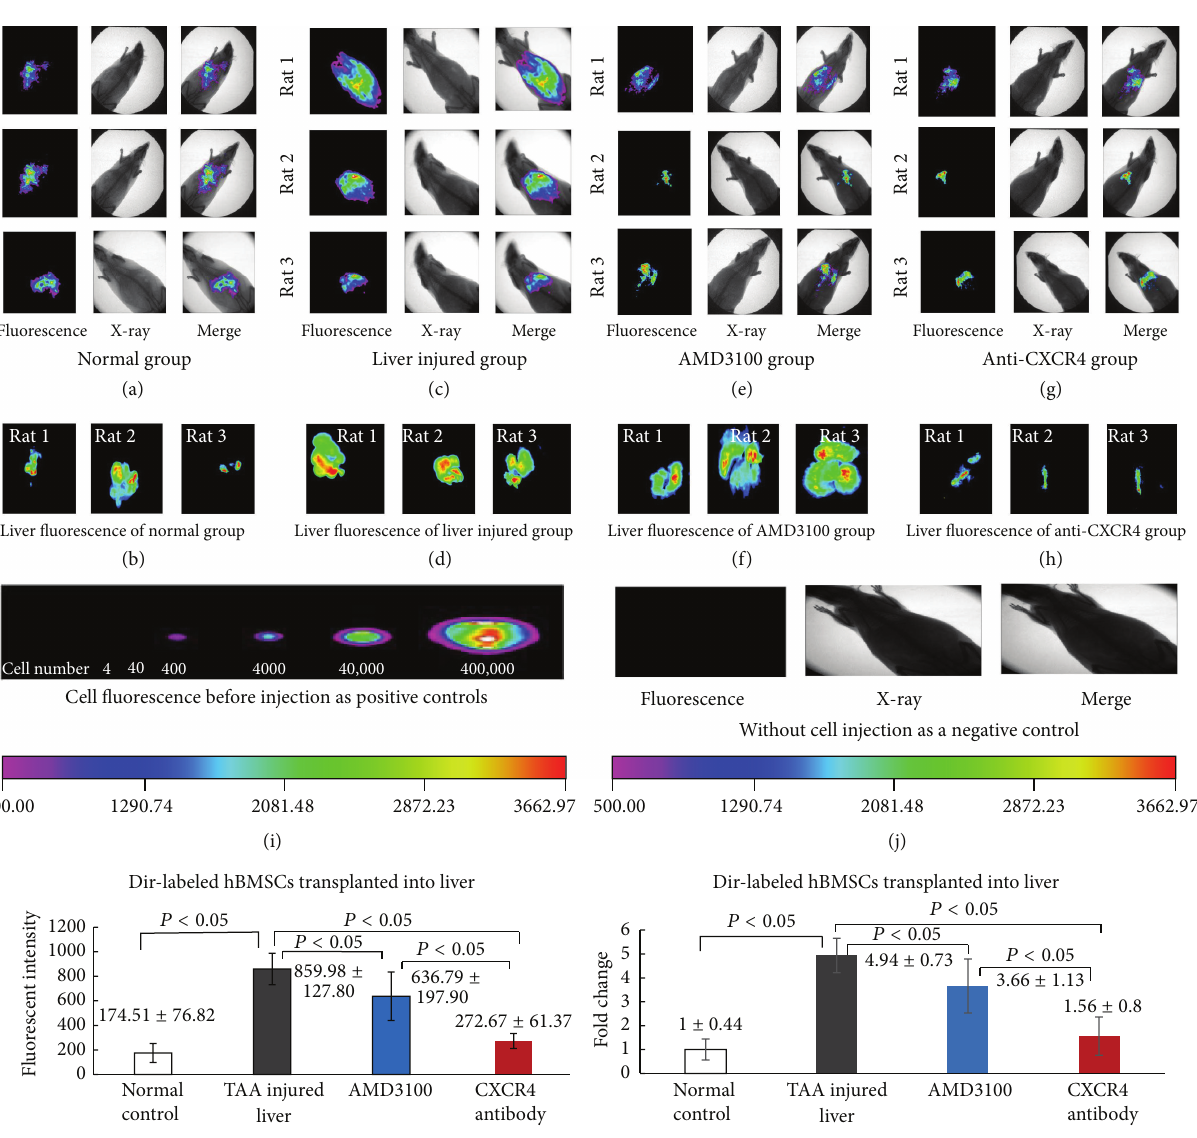
Figure5:BMSCsmigrationininjuredliverinhibitedbyanti-CXCR4antibodyandAMD3100.(a)Thefluorescentintensityofnormalratsafter Dir-labeled BMSCs injection; (b) the fluorescent intensity of dissected normal livers after Dir-labeled BMSCs injection; (c) the fluorescent intensity of rats with TAA induced liver injury after Dir-labeled BMSCs injection; (d) the fluorescent intensity of dissected TAA injured livers after Dir-labeled BMSCs injection; (e) the fluorescent intensity of rats with TAA induced liver injury after Dir-labeled BMSCs and AMD3100 injection at the same time; (f) the fluorescent intensity of dissected injured livers after Dir-labeled BMSCs and AMD3100 injection at the same time; (g) the fluorescent intensity of rats with TAA induced liver injury after anti-CXCR4 antibody pretreated and Dir-labeled BMSCs injection; (h) the fluorescent intensity of dissected injured livers after anti-CXCR4 antibody pretreated and Dir-labeled BMSCs injection; (i) Dir-labeled BMSCs before injection were as positive control; (j) rats without cell injection were as negative control; (k) the fluorescent intensity value and fold changes of the dissected livers of each group; the differences were statistically